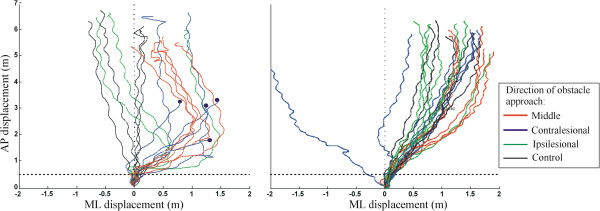
Representative diagram of walking strategies adopted by 2 participants. The left panel is the walking pattern of a collider while the right panel consist of walking pattern of a non-collider. Note the collisions experienced by participant #12 [# omissions on Bells test = 9] (see left panel), which are represented by the black dots, and the absence of collision for participant #6 [# omissions on Bells test = 0] (see right panel).